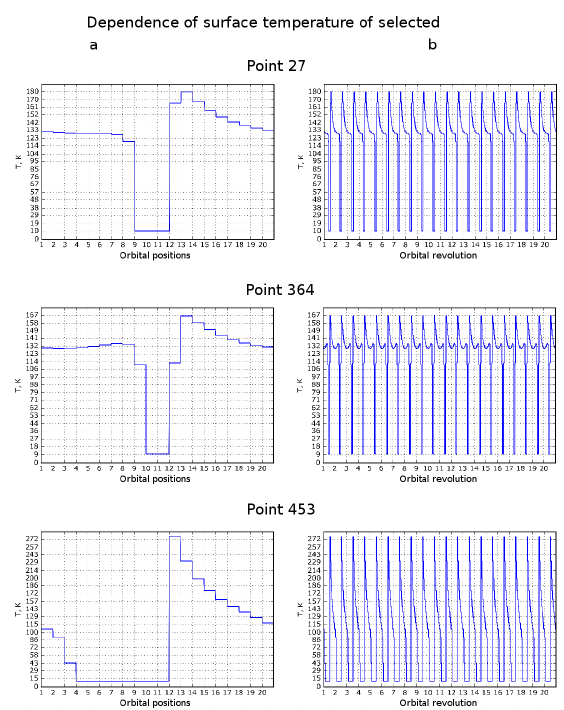
Figure 3. Dependence of surface temperature of selected points: a) for one orbital revolve and b) for 20 orbital